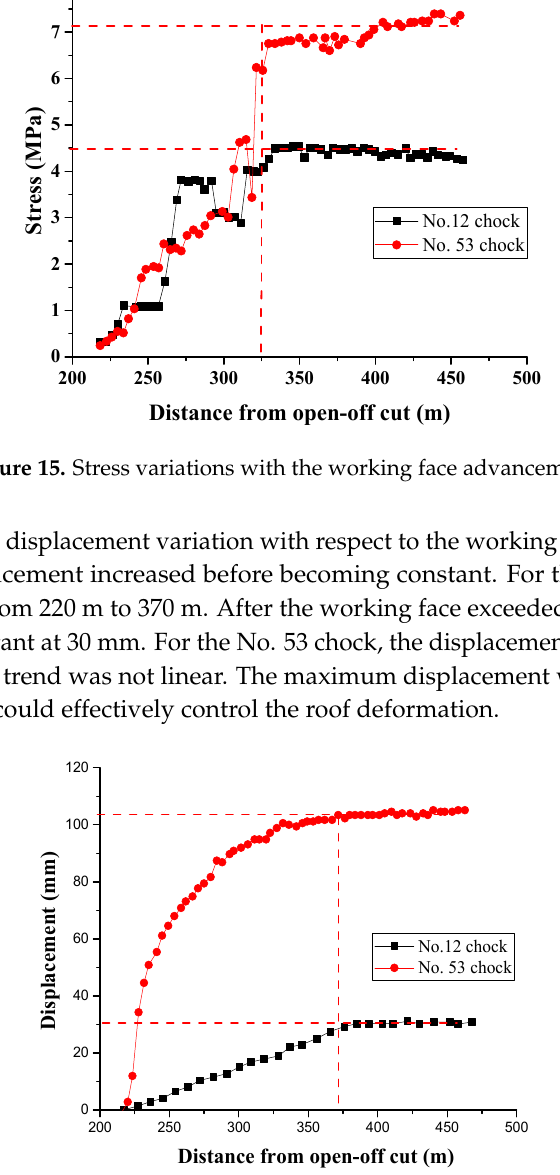
Figure 16. Displacement variations with the working face advancement.